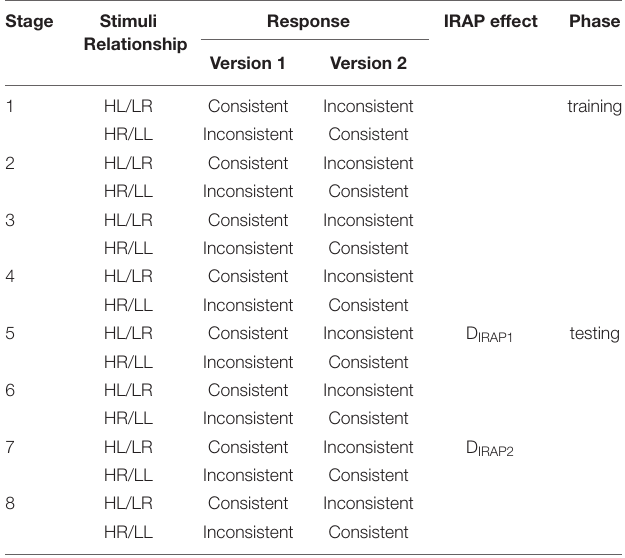
TABLE 1 | The construct of IRAP